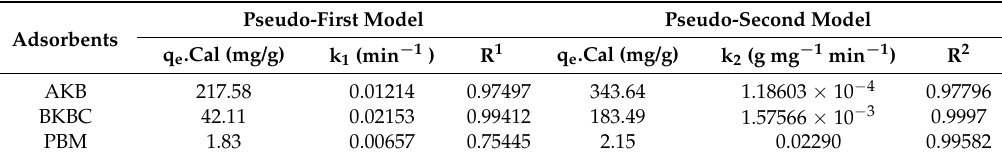
Table 4. Adsorption kinetics parameters of MB on samples.